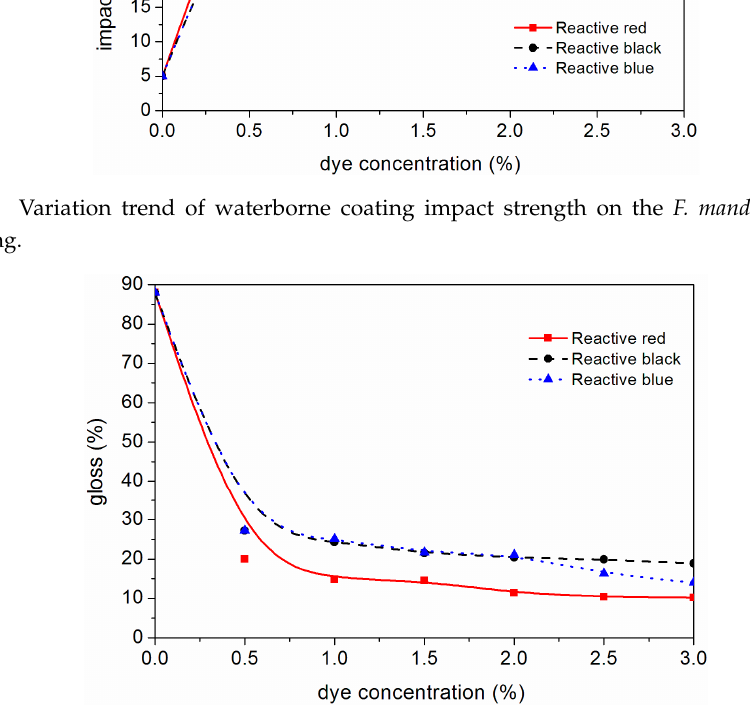
Figure 11. Variation trends of gloss of waterborne coating on the F. mandshurica veneer after dyeing.